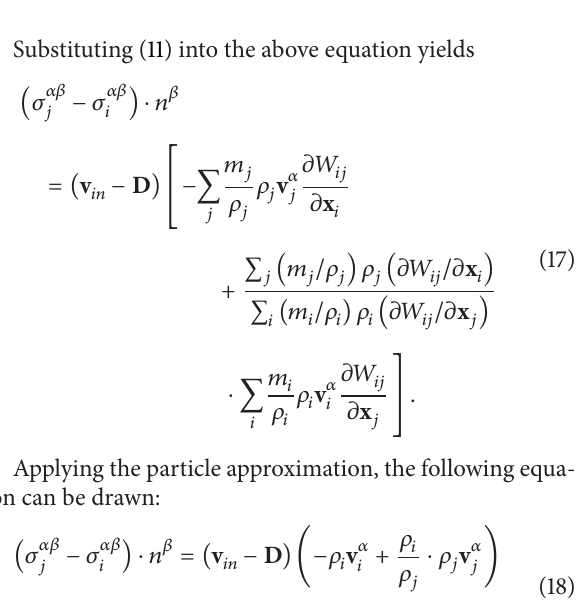
Inside Thickness radius of shell (m)